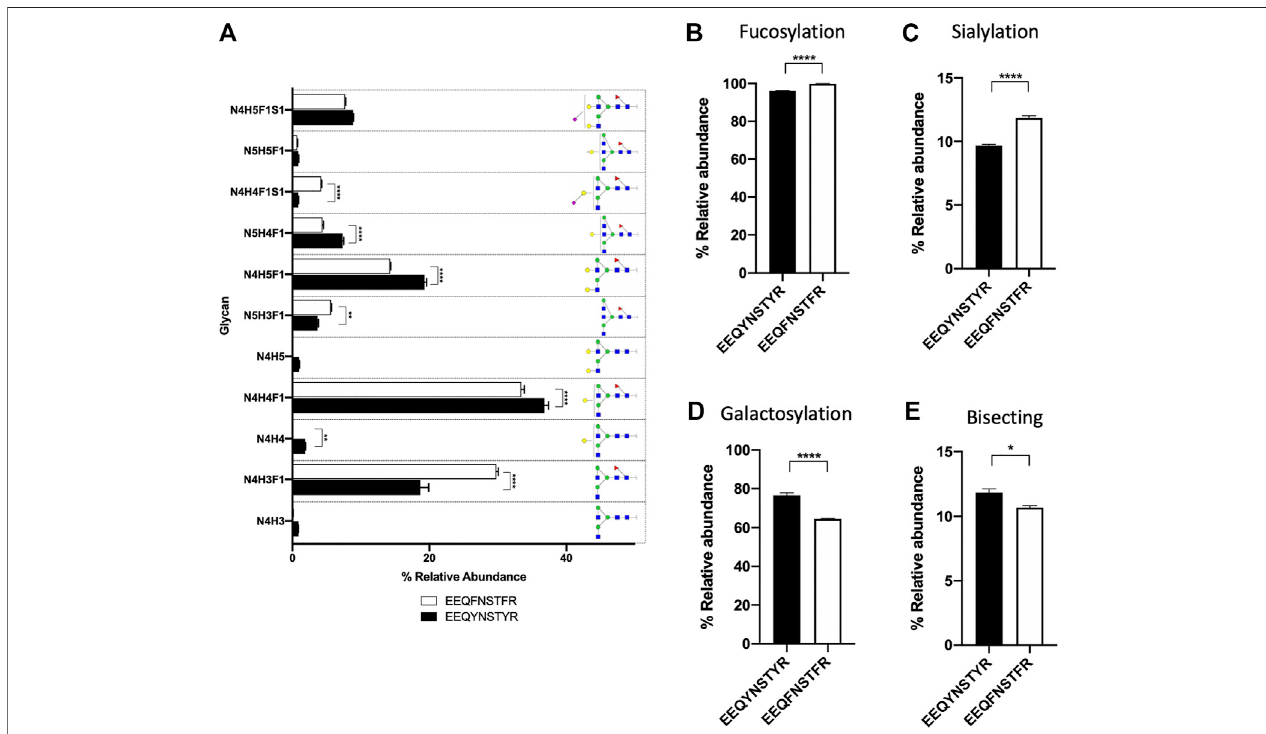
FIGURE 3 | (A) Bar chart summarises the relative abundance (in percentage) of glycans of EEQY N STYR and EEQY N STYR (only those with relative abundance higher than0.5% areplotted).Relativeabundance of (B) fucosylation, (C) sialylation, (D) galactosylation,and (E) bisectingstructureofserum IgG. (A) ,Two-way ANOVA followed by Bonferroni ’ s post hoc test, multiple comparisons were performed between EEQY N STYR and EEQY N STYR, n (cid:2) 4; (B – E) , Student ’ s t-test; n (cid:2) 4, * p < 0.05, ** p < 0.01; **** p <